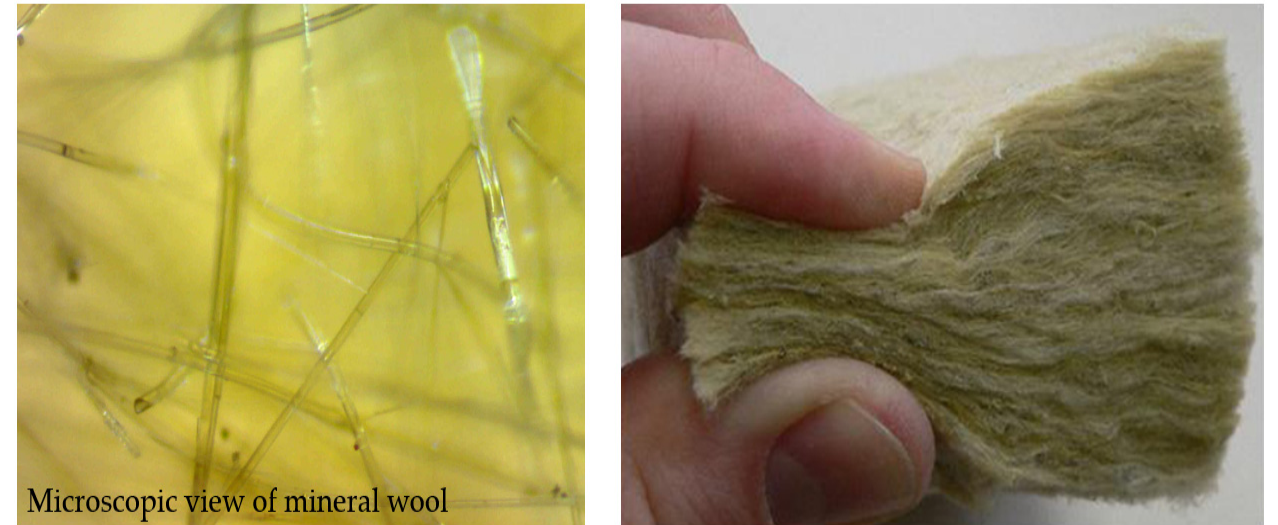
Figure 2. A microscopic view and close-up of mineral wool [23].